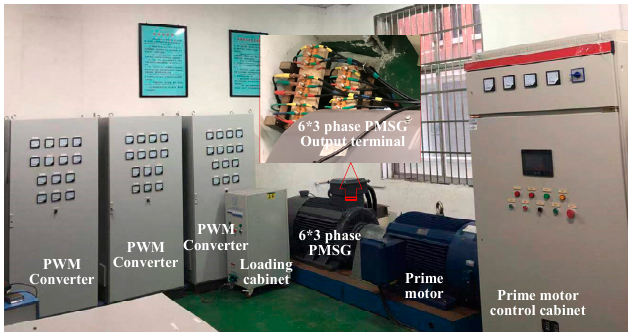
Figure 14. 6* three-phase PMSG experimental platform.